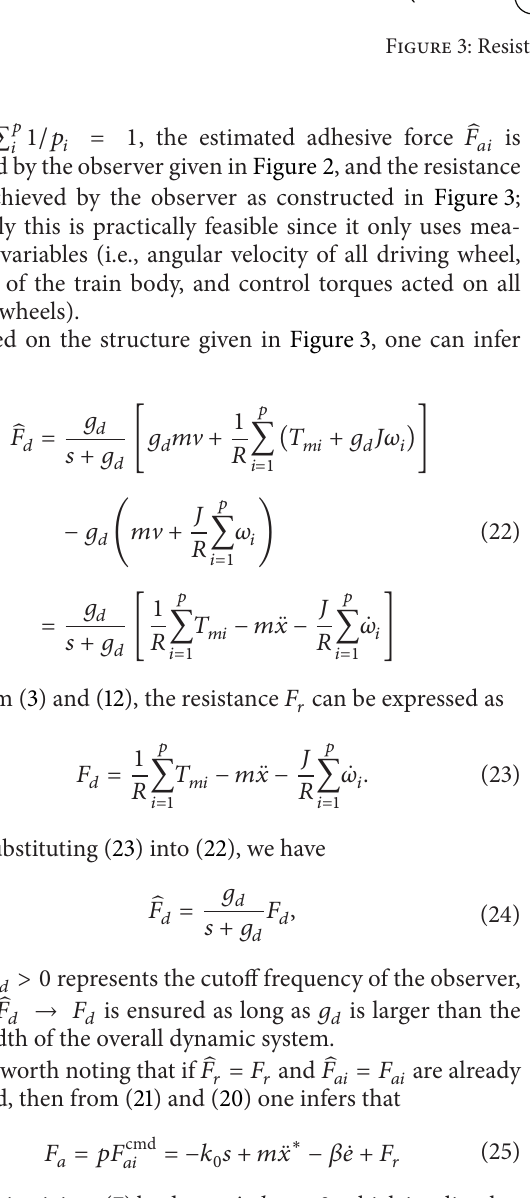
Figure 3: Resistance observer (